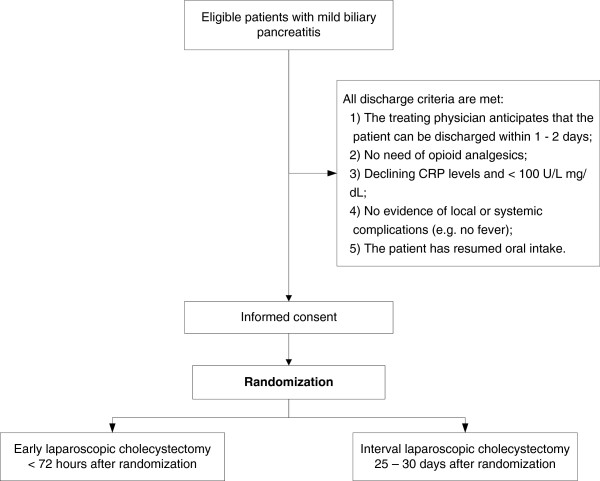
PONCHO overview of eligibility and group allocation.